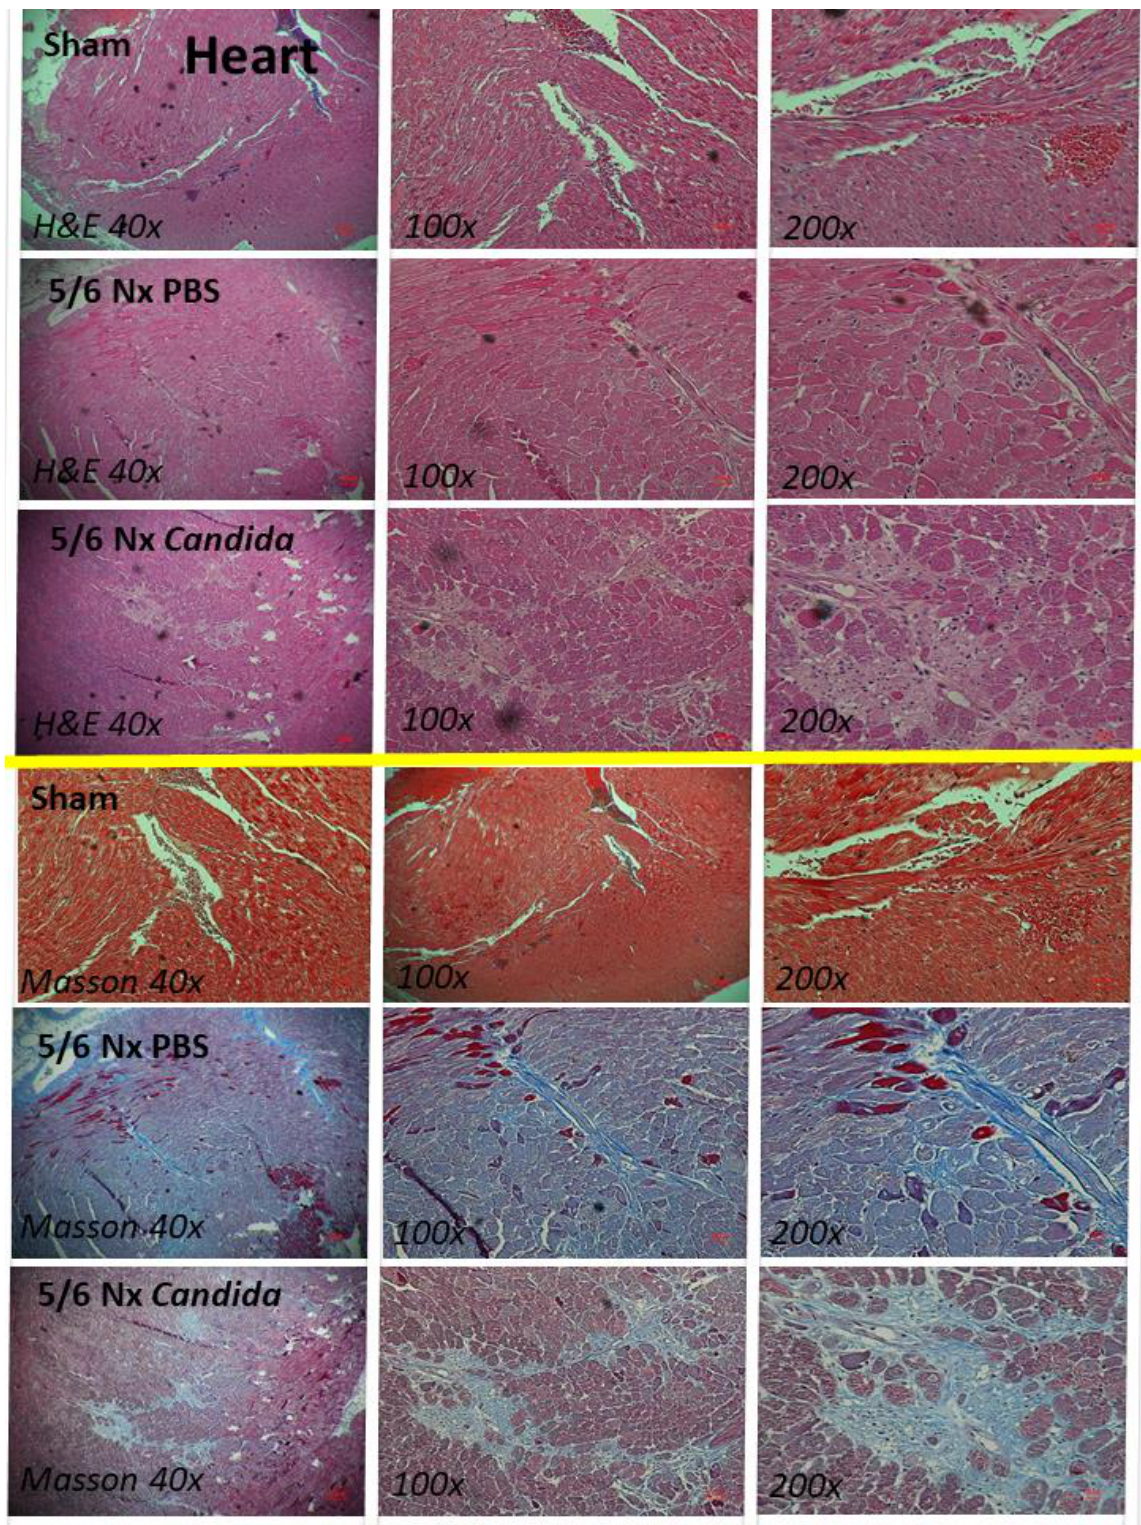
Figure 5. The representative heart histopathological pictures stained by hematoxylin and eosin (H&E) ( upper part ) or Masson’s trichrome color ( lower part ) (original magnification 40 – 200×) of Sham control, 5/6 nephrectomized mice with phosphate buffer solution (5/6 Nx PBS) or Candida administration (5/6 Nx Candida ) are demonstrated.